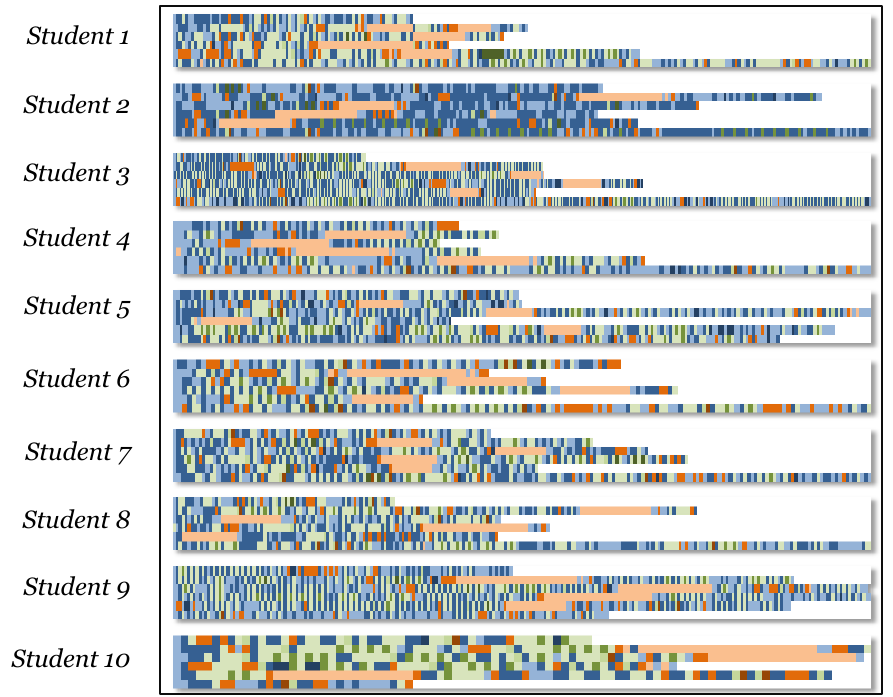
Figure 6. Behavioral interaction pattern for each individual student in Course